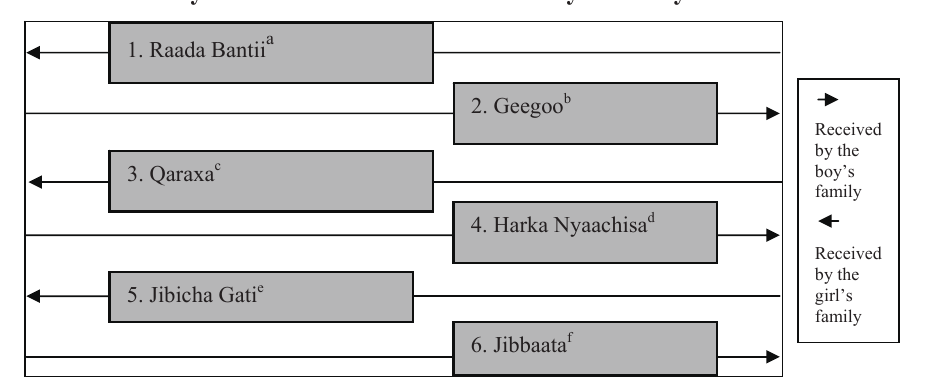
Fig. 1. Animal Gifts and Exchanges Involving Marriage (Bridewealth) and Inheritance Fig. 1. Animal gifts and exchanges involving marriage (Bridewealth) and Girl’s Family Boy’s Family/the Girl